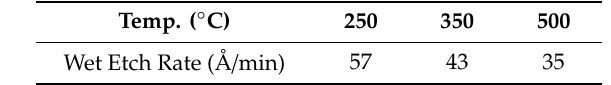
Figure 6. Transmission electron microscopy (TEM) images for step coverage of the RPALD SiN x film as a function of deposition temperature in a wide pattern at ( a ) 250 °C, ( b ) 350 °C, and ( c ) 500 °C and in a narrow pattern at ( d ) 250 °C, ( e ) 350 °C, and ( f ) 500 °C.